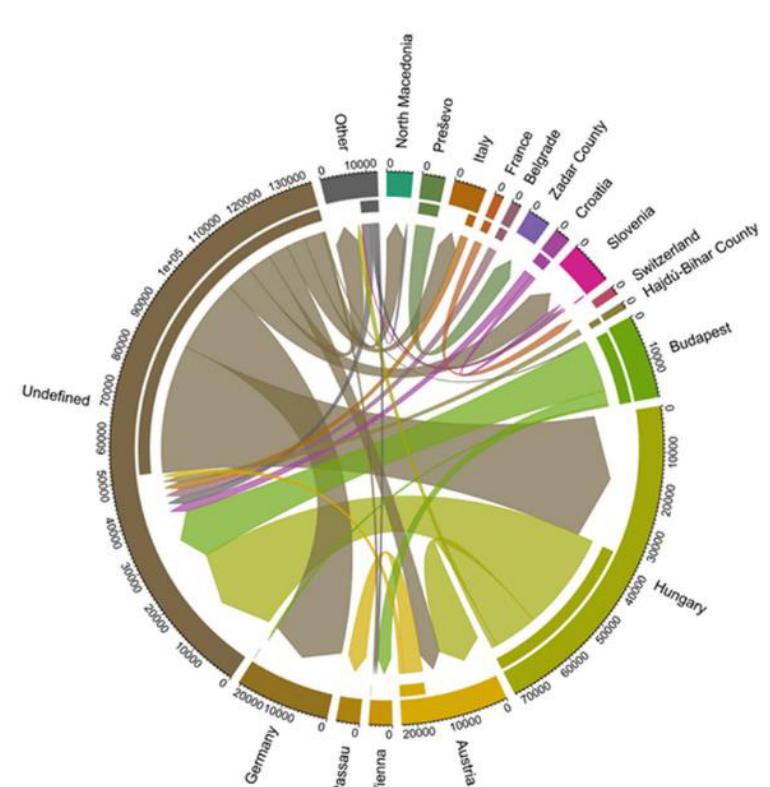
Figure 18. Chord diagram showing the flow of refugees across the Balkan route (based on numbers mentioned in the text).